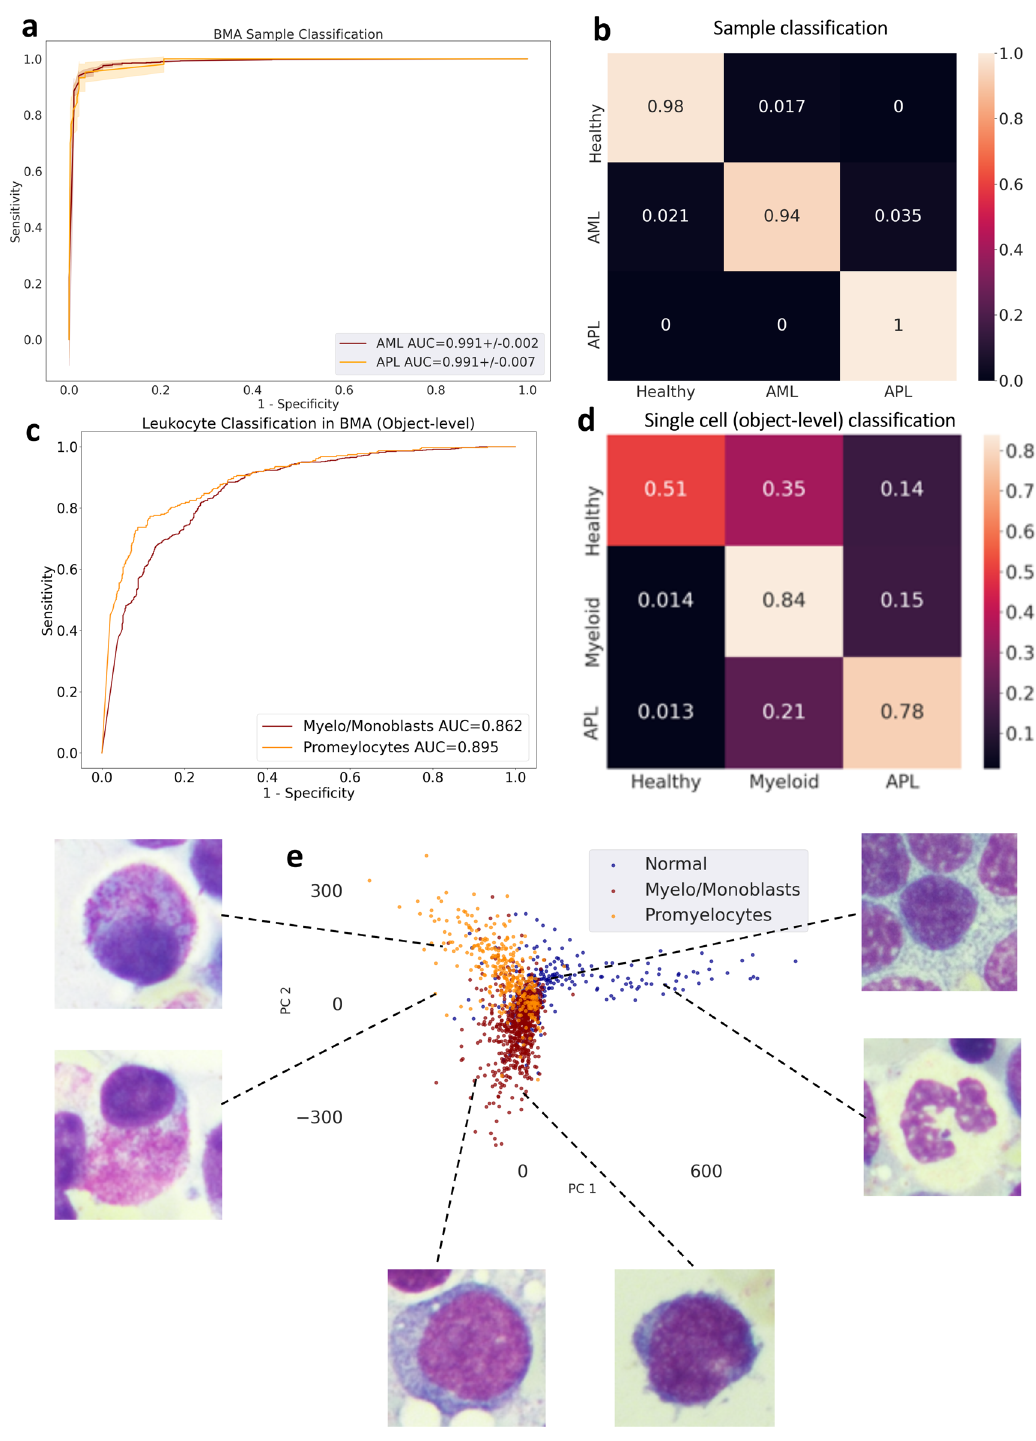
Figure 5. Acute myeloid leukemia detection in bone marrow aspirates. ( a ) Receiver operating characteristic (ROC) curve for sample-level classification on the hold out validation set. ( b ) Confusion matrix for sample classification on the validation set. ( c ) ROC curve for cell-level classification on the cell image test set. ( d ) Confusion matrix for cell classification (promyelocytes vs other) on the cell image test set. ( e ) PCA visualization of the convolutional representations learned by MILLIE of the individual cells in the test